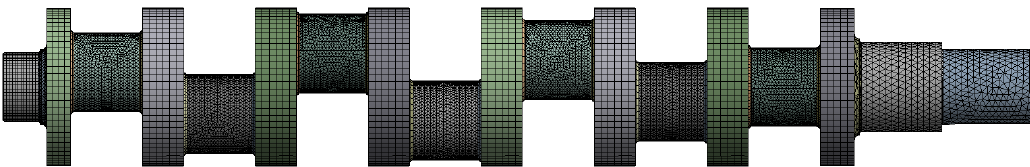
Figure 22. Diagram of the refined crankshaft meshing.